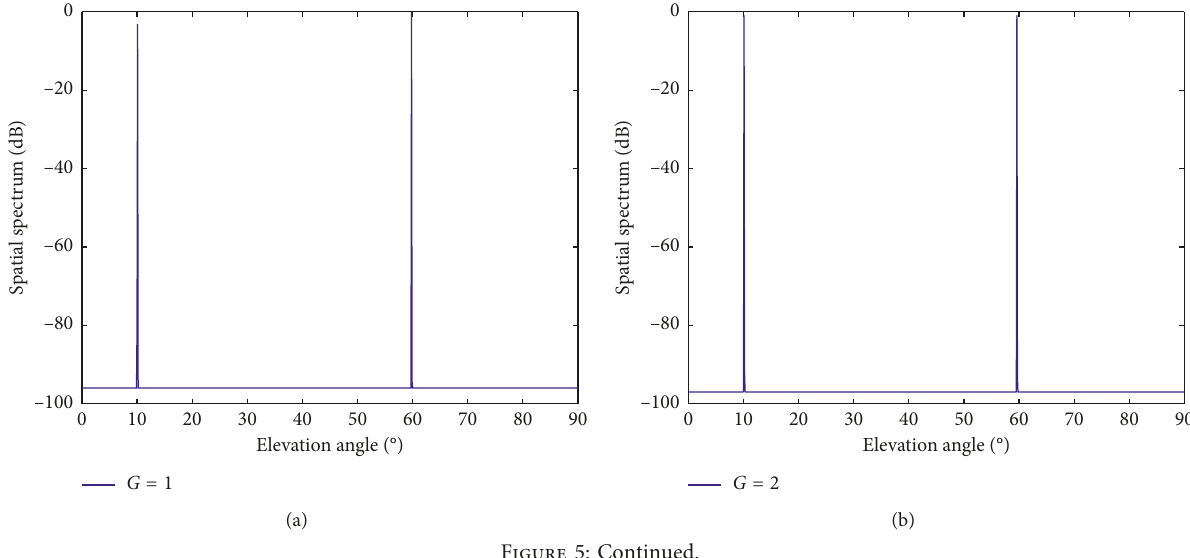
Figure 4: The comparison of coherent source spectrum (SNR � 0dB). (a) Spatial spectrum by SR method. (b) Spatial spectrum by standard 2D MUSIC method. (c) Elevation angle spectrum ( φ � 90 °